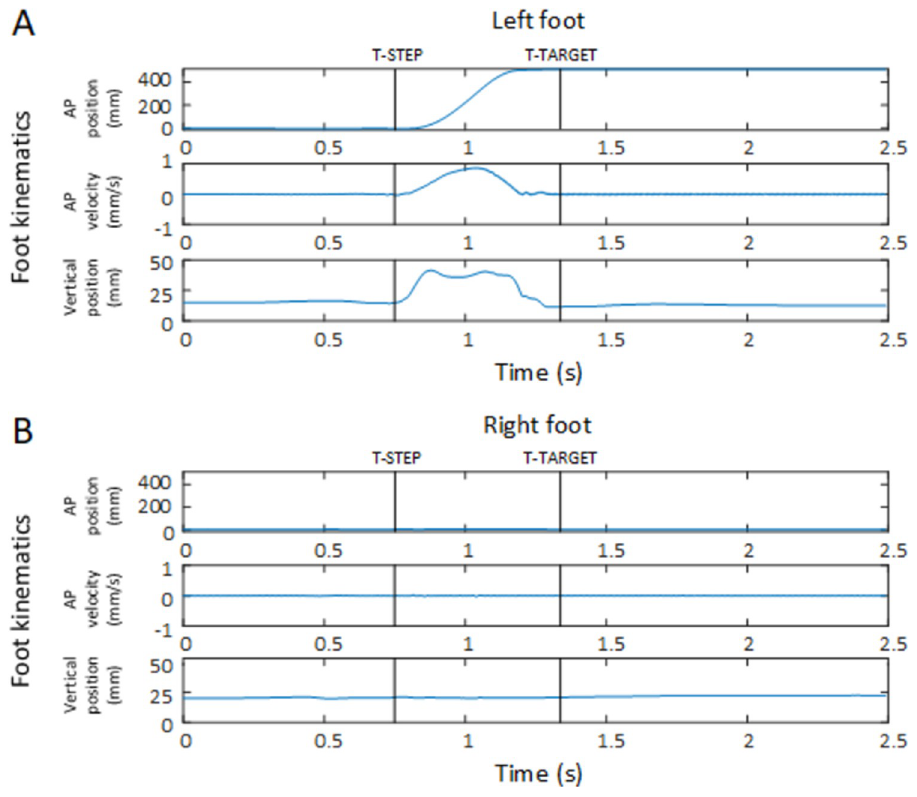
point step onset; T-TARGET: time point step onto pressure-sensitive target mat; AP: